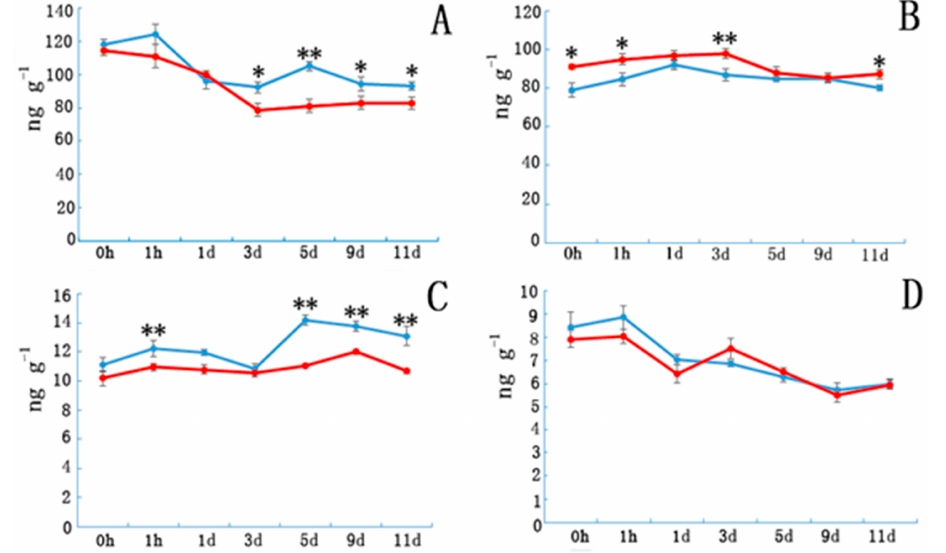
Figure 2. The plant hormone content in etiolated and non ‐ etiolated samples during the different cutting periods. ( A ) Indole acetic acid (IAA), ( B ) abscisic acid (ABA), ( C ) gibberellic acid (GA 3 ), and ( D ) zeatin riboside (ZR) contents (ng/g) at different time points. Etiolated (E) treatment (blue) and control (non ‐ etiolated, NE) treatment (red). * and ** denotes a significant difference (0.01 < p < 0.05, α = 0.05) or an extremely significant difference ( p < 0.01, α = 0.05) between treatments. Error bars represent the standard deviation.